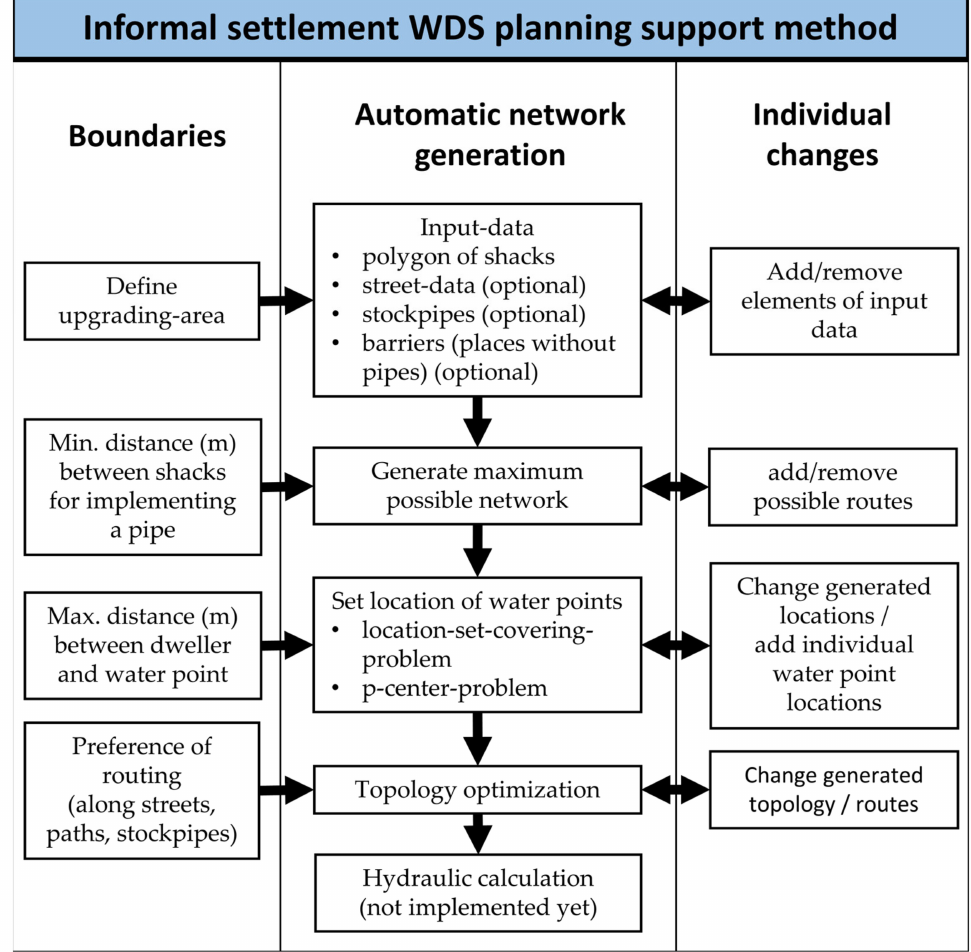
Figure 1. Structure of the method: The central element of the method is the automatic network generation. For this, boundary conditions must be specified by the user. If desired, individual changes can be integrated at any time, which are taken into account in the subsequent step of automatic network